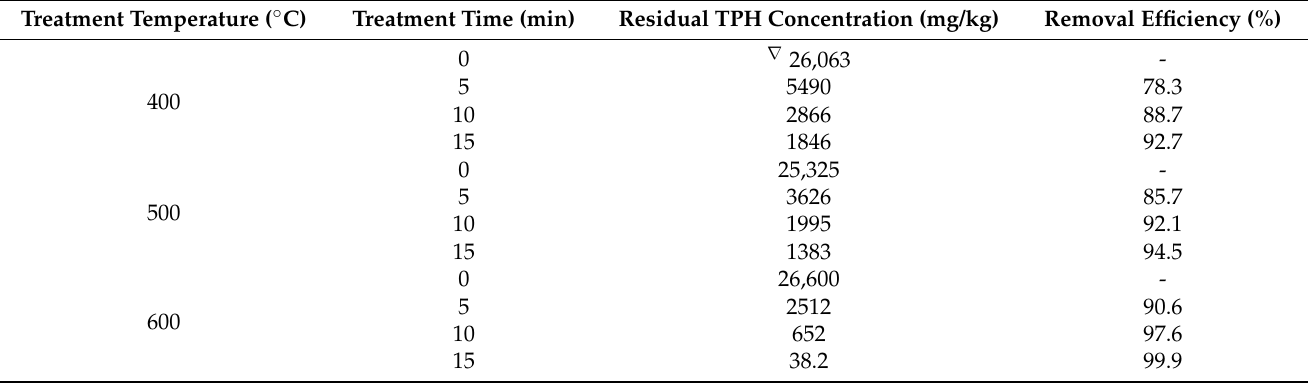
Table 5. Residual TPH concentration and removal efficiency by treatment temperature and time.